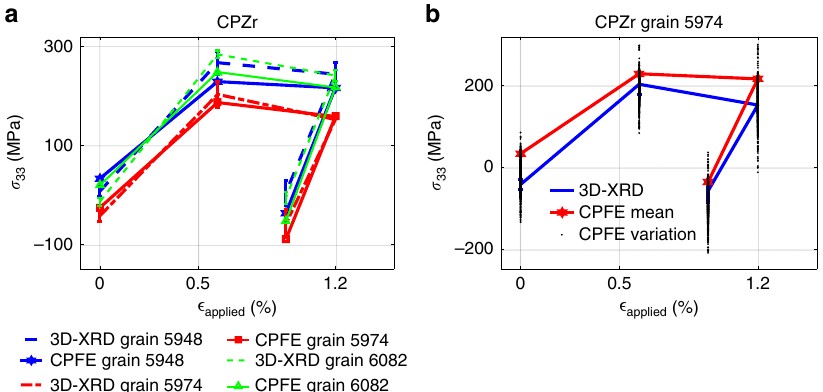
Fig. 5 Examples of σ 33 stress drop observed in some selected grains. a Average measured and calculated σ 33 , and ( b ) variation of σ 33 calculated at each integration point assigned to grain